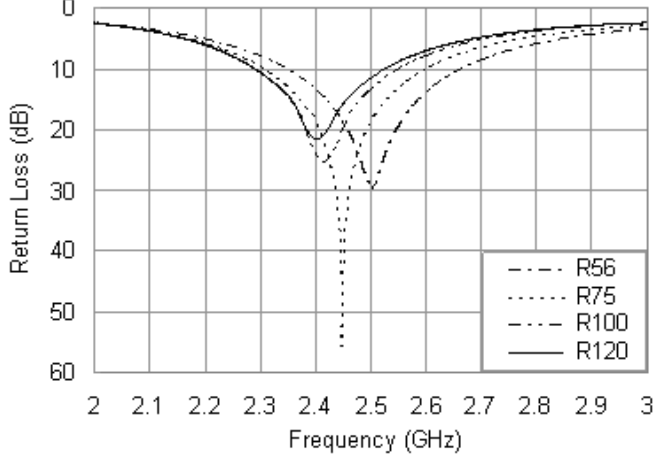
Figure 9. Simulated return loss curves of the proposed antenna along with the installation base.